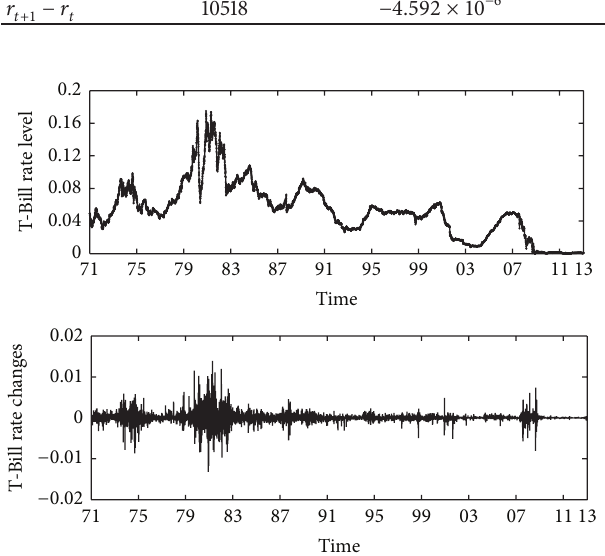
Figure 1: The time series of the level and changes in the 3-month Treasury Bill rates, from January 1971 to February 2013.